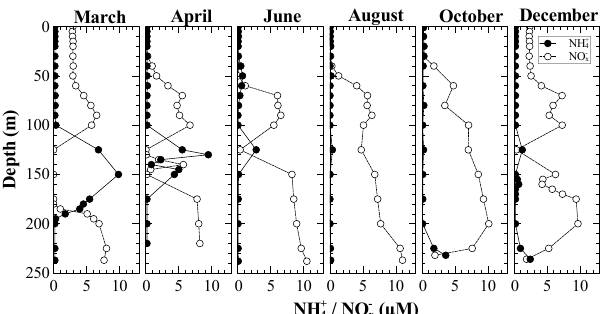
+ , filled circles, solid line) and com- Figure 4. Ammonium (NH 4 bined nitrite–nitrate (NO − x , open circles, dotted line) concentrations (µM) at BY15 over the whole sampling